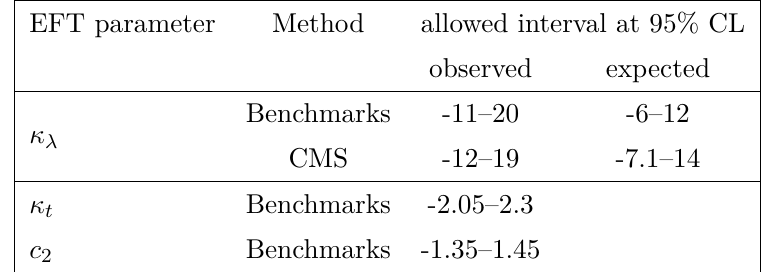
Table 8 . The observed and expected 95% CL intervals on EFT parameters from benchmark interpolation and from CMS public results when available